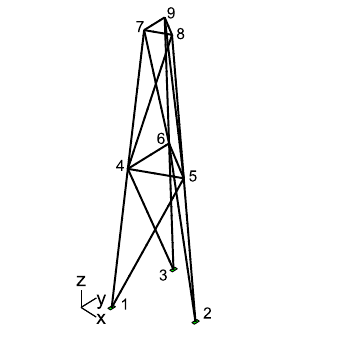
Figure 11. Finite element model of the tower example used in the simulated analysis.